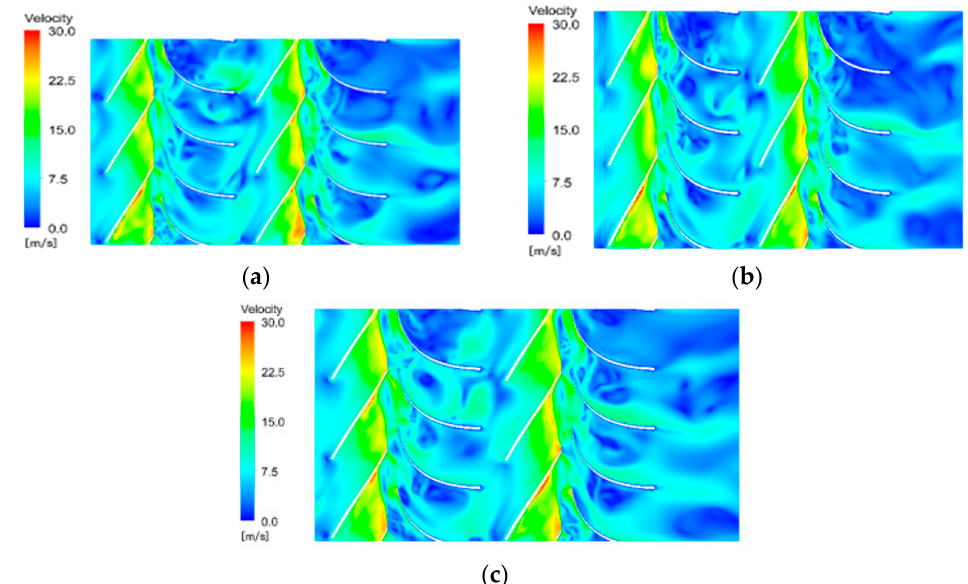
Figure 12. Velocity distribution on first-stage impeller-guide vane B2B view: ( a ) 1400 kg/m 3 ; ( b ) 1900 kg/m 3 ; ( c ) 2800 kg/m 3 .